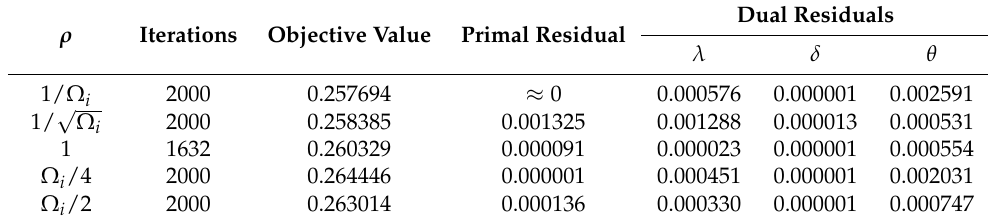
Table 3. Penalty term ( ρ ) optimal scenario